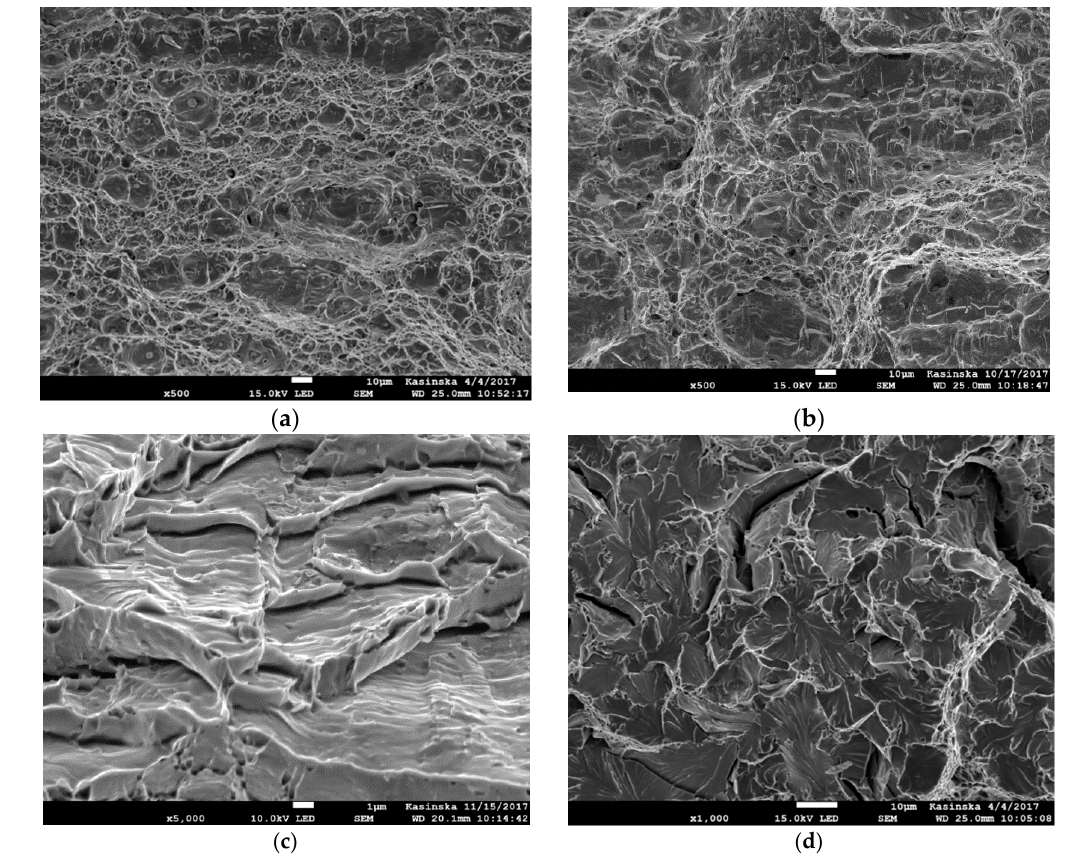
Figure 5. Images of the fracture surfaces of different specimen shapes. ( a ) Dimples along the fracture surface in specimen C1, material N, temperature +20 °C. ( b ) Dimples along the fracture surface in specimen PN, material N, temperature +20 °C. ( c ) Ductile fracture due to the dislocations glides along the slip planes; specimen PR, material HW, temperature − 20 °C. ( d ) Cleavage fracture next to the circumferential notch in specimen C04, material NW, temperature − 50 °C.